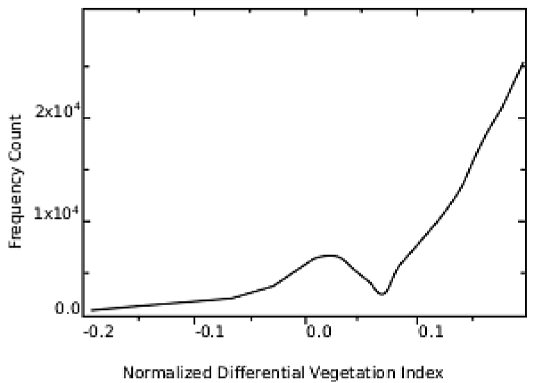
Figure 6. Frequency distribution of the NDVI values in shadowed